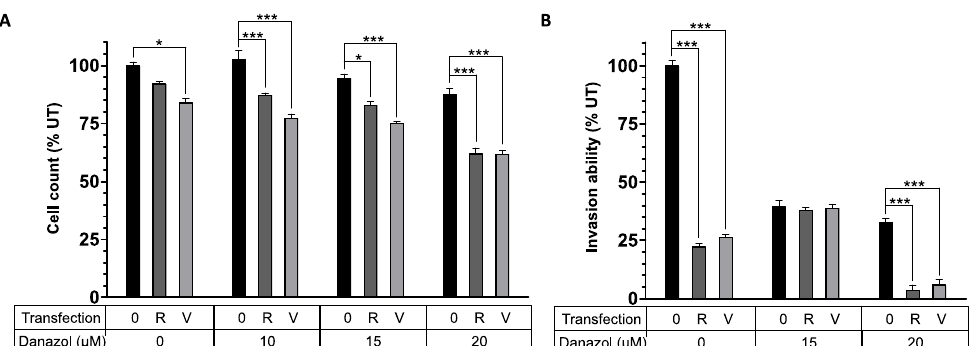
Figure 6. Therapeutic NF70/siRNA NP and danazol co-treatment synergistically reduced endometriotic cell proliferation and invasion. ( A ) Amount of peritoneal endometriotic cells 48 h after co-treatment measured using methylene blue proliferation assay. ( B ) Invasive capability of endometriotic peritoneal cells co-treated with NP–danazol through the extracellular matrix. Cells were transferred into Matrigel invasion chambers 48 h after co-treatment followed by a 24 h attachment period and 24 h chemoattraction to FBS. Invaded cells were counted under inverted microscope. All of the data ( A , B ) were collected from 3 independent experiments and results were normalized to UT cells. Error bars represent SEM. * p < 0.05, *** p < 0.001, two-way ANOVA, Tukey post hoc . Danazol final micromolar concentration is shown. 0—no NP transfection; R—NF70/siRRM2; V—NF70/siVEGF.